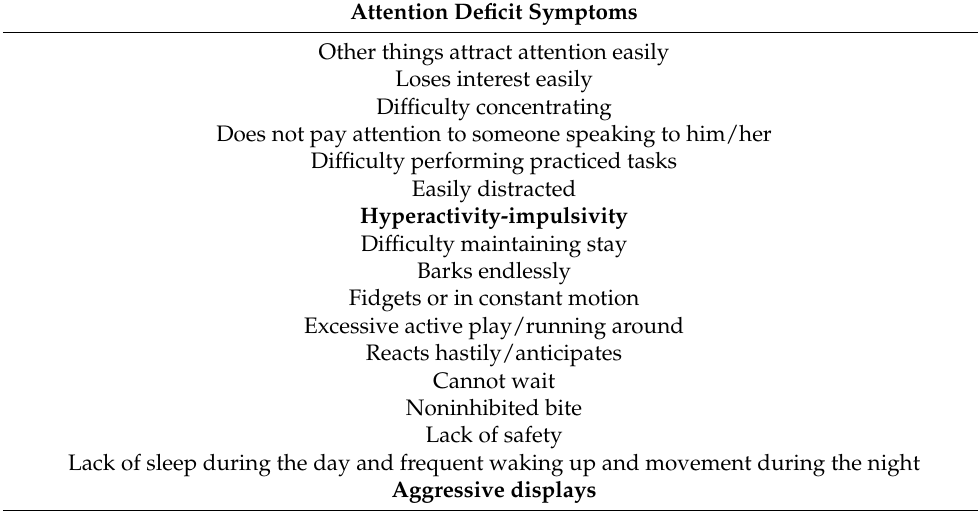
Table 1. ADHD-like